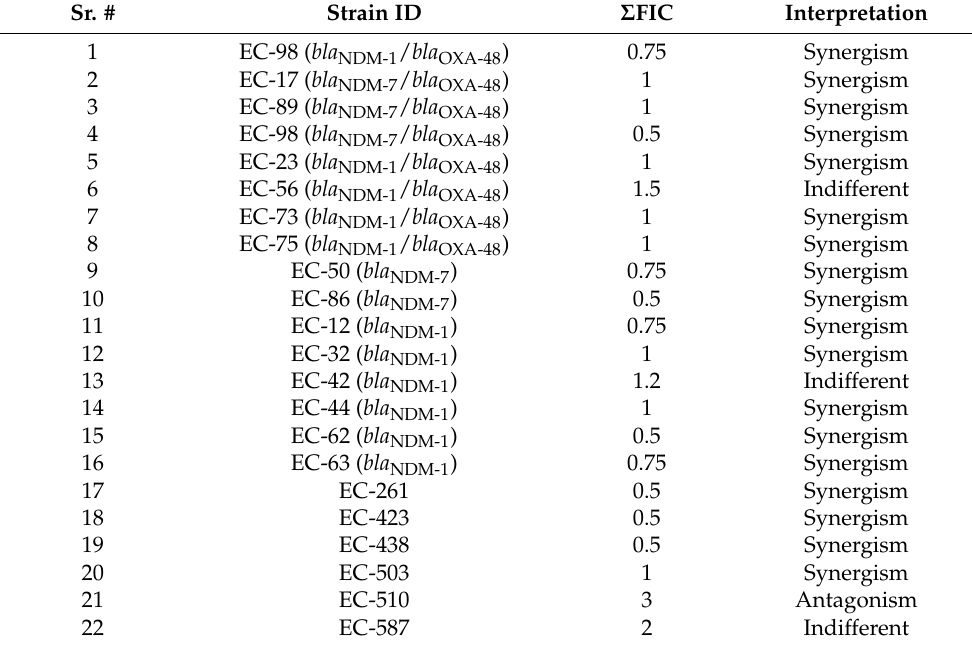
Table 4. AgNPs and MEM interaction determined by Σ FIC